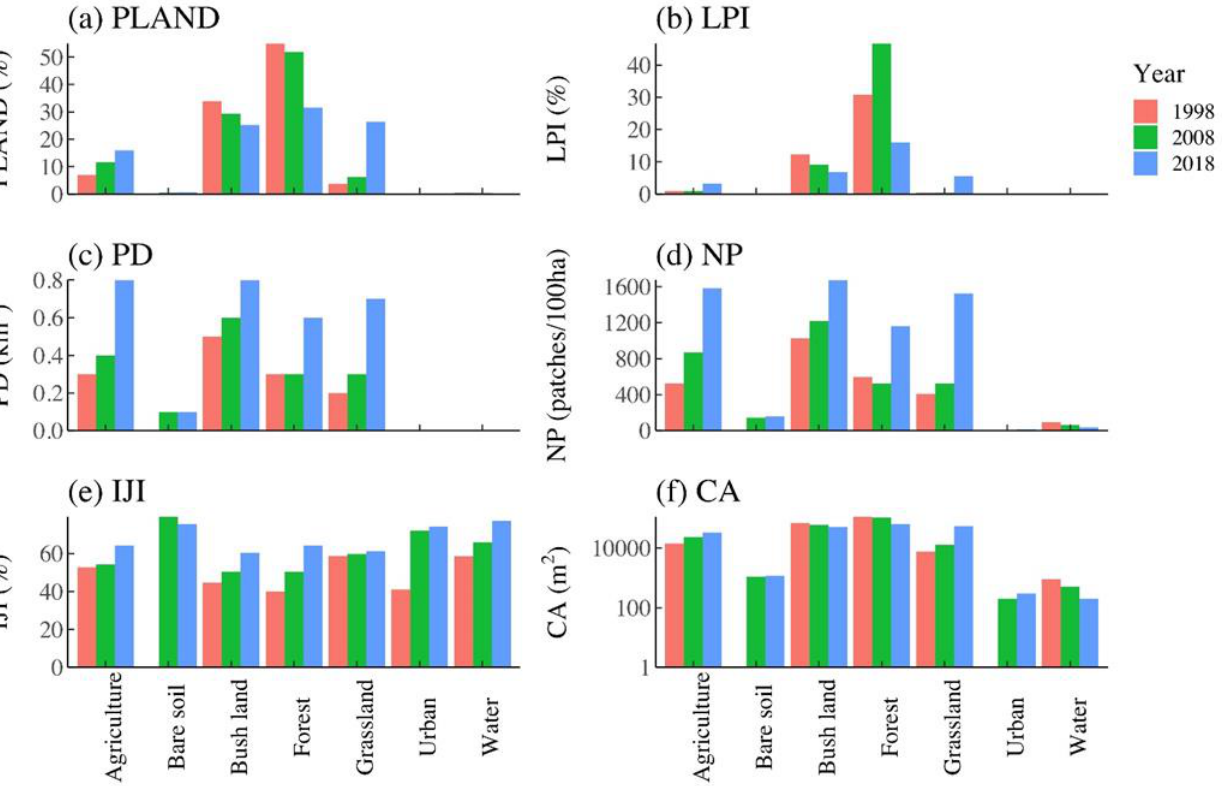
Figure 3. Temporal shifts in total area coverage of ( a ) percentage of landscape (PLAND), ( b ) largest patch index (LPI), ( c ) patch density (PD), ( d ) number of patches (NP), ( e ) interspersion and juxtapo- sition index (IJI), and ( f ) total class area (CA) for the different land-cover categories as indicated